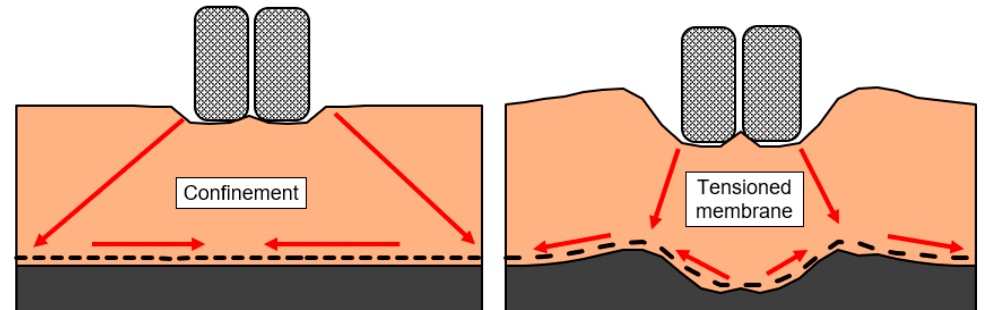
Figure 16. Two mechanisms providing support stabilisation (via confinement) ( left ) and reinforce- ment (via tensioned membrane ( right )) (adapted from [123]). ment (via tensioned membrane ( right )) (adapted from